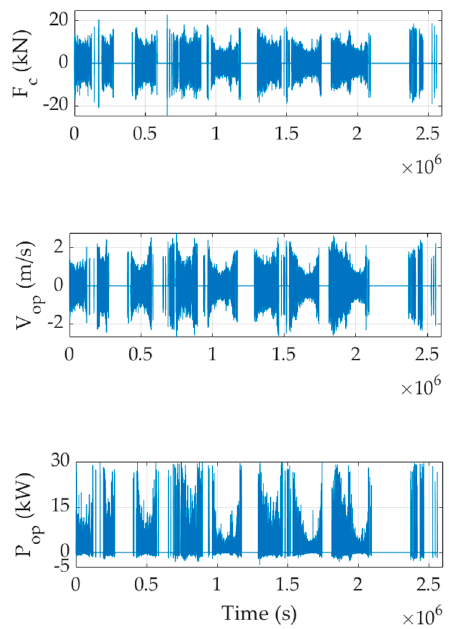
Figure 12. Constrained buoy dynamic inputs in March.